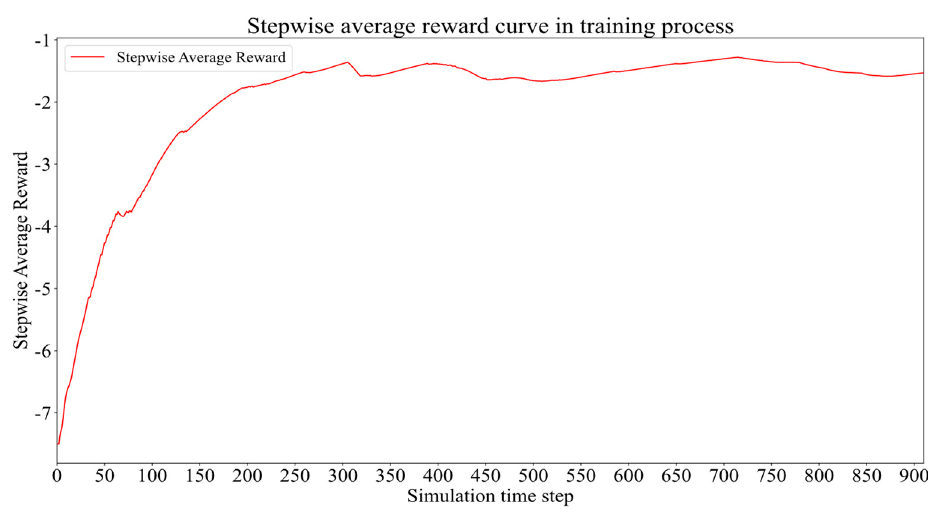
Figure 8. Stepwise average reward curve during